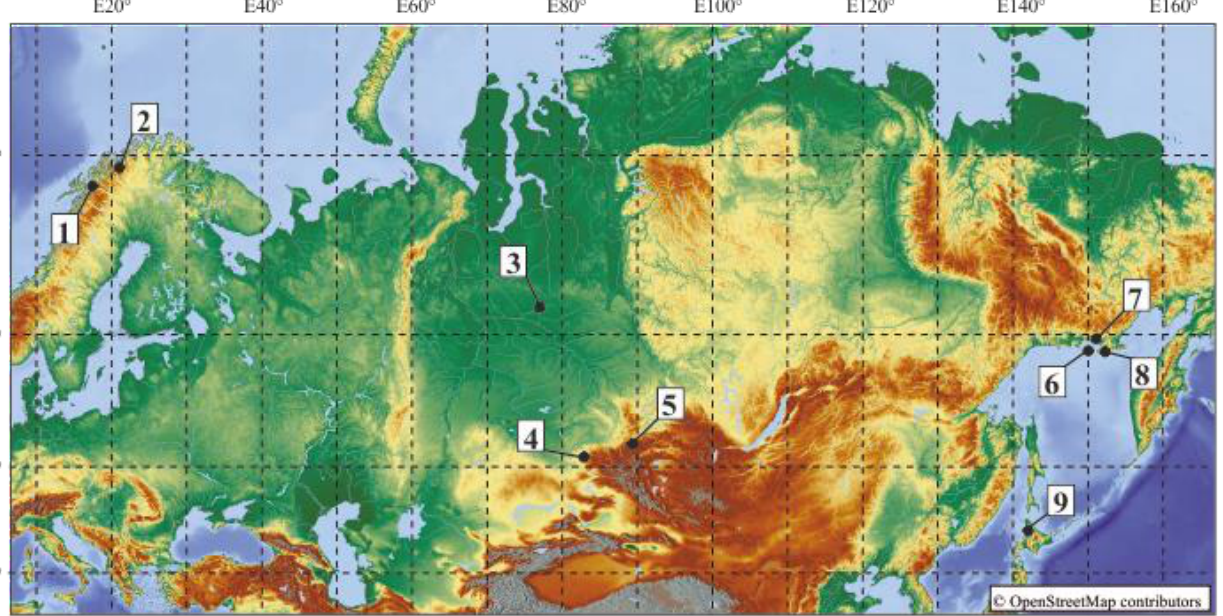
Figure 1. Geographical distribution of the sampling localities for Paranoplocephala kalelai . The samples from the localities 3–8 were collected by the authors. The samples from the localities 1, 2, 9 are given according to publications [4,5,7], respectively. The locality numbers refer to Table 1. The green, yellow, and orange colors indicate the elevation of the terrain in order from green to orange.